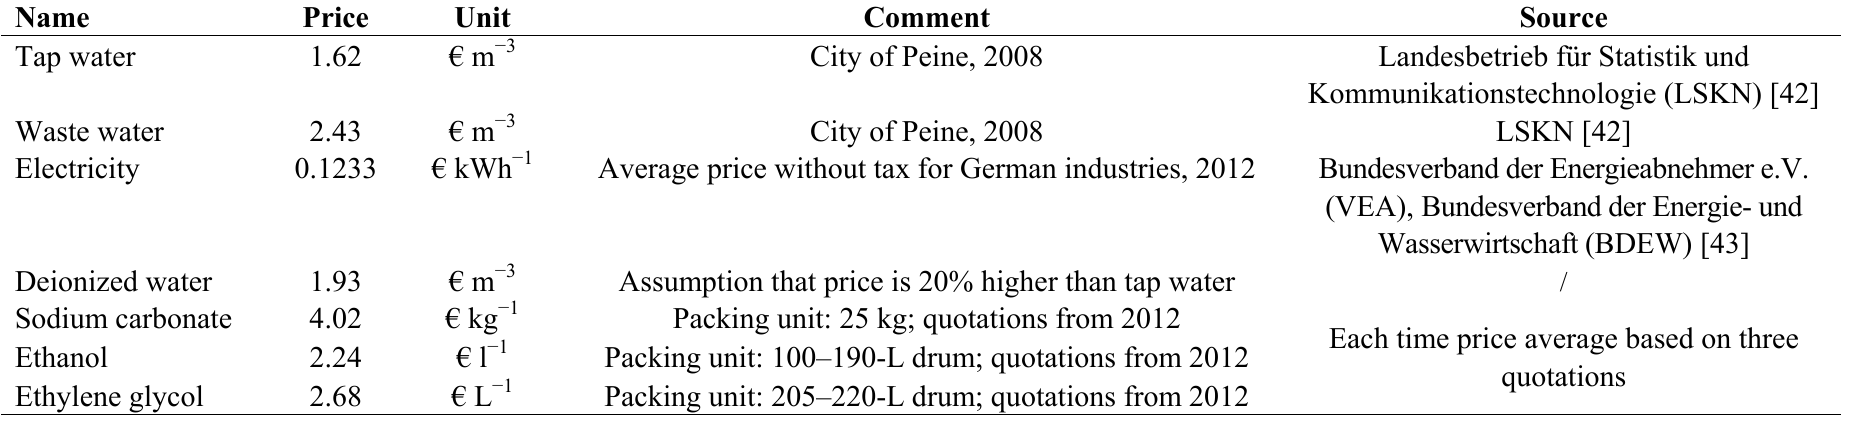
Table C-1. Adopted prices for operating supplies, reactants and electricity for the cost analysis.